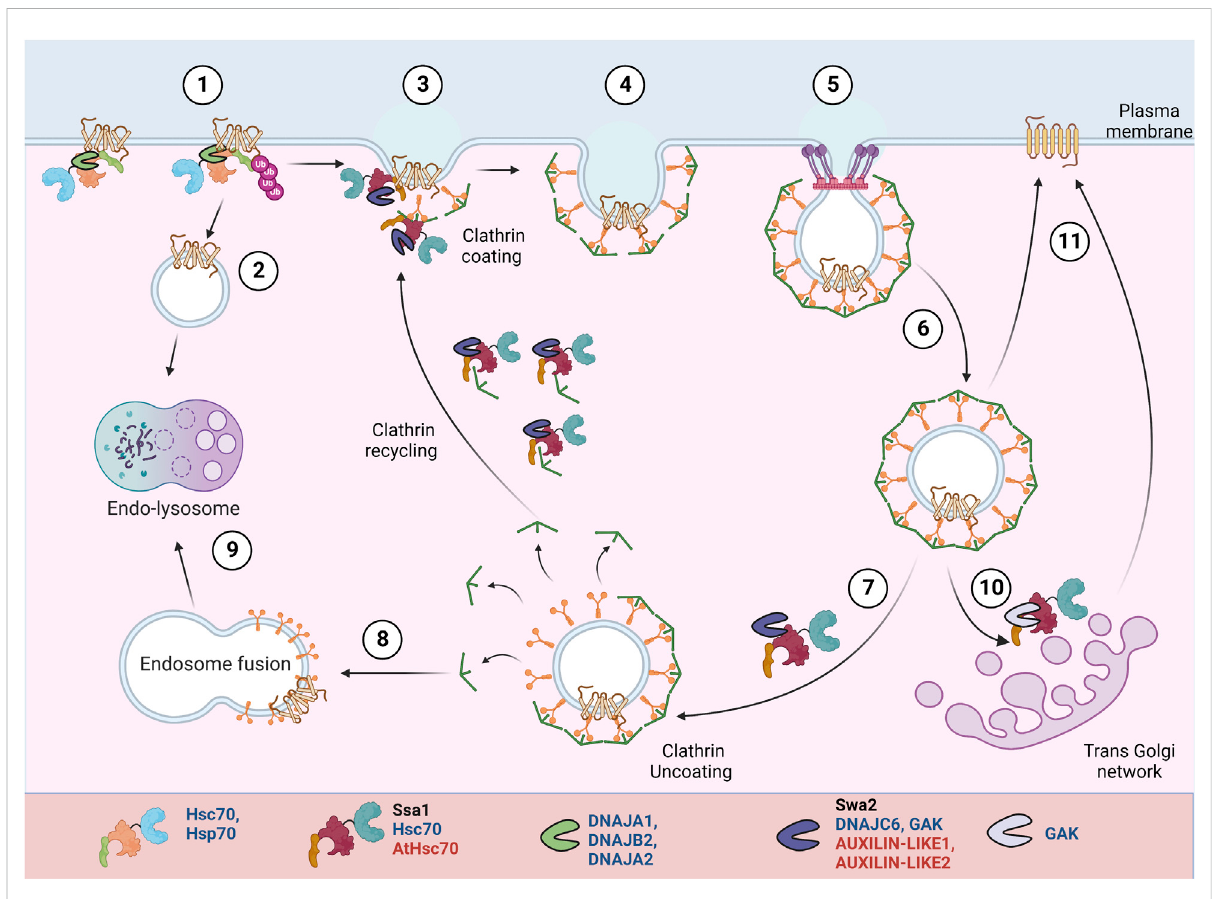
FIGURE 4 PM protein recycling/degradation by clathrin mediated endocytosis. In response to misfolding or stimuli mediated conformational changes, Hsp70:JDPsmediatePMproteins ’ ubiquitination H (1)(Bagdanyetal.,2017).Theproteinsundergoclathrin-independent(2)orclathrin-dependent(3- 6) endocytosis. They can be targeted for lysosomal degradation (8-9) or recycled back to PM (10-11). A speci fi c set of Hsp70:JDPs regulate clathrin- dependent endocytosis Y,H,A , by mediating the membrane invagination, clathrin exchange, uncoating and recycling of clathrin to new